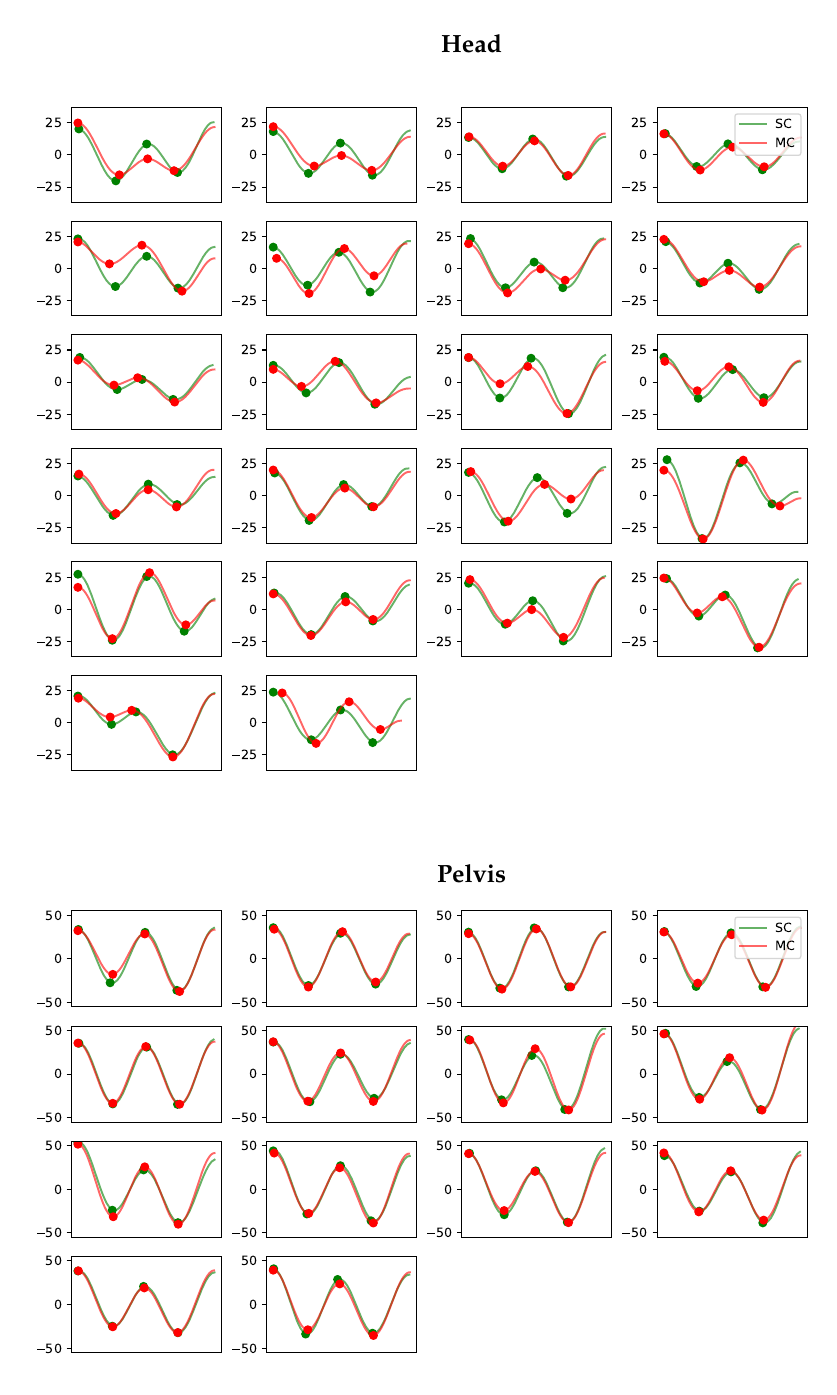
Figure A13. Vertical displacement signals per stride for the head and pelvis for horse 14. Each subplot contains the matched stride segments for the single-camera markerless system (SC) in green and the multi-camera marker-based system (MC) in red. The y-axis shows the vertical displacement in millimeters. The four dots on each curve indicate the positions of the two peaks and two valleys extracted using the approach in Section